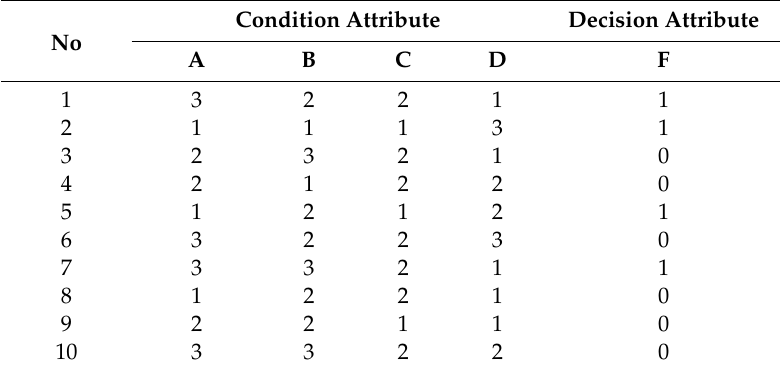
Table 3. Sample data